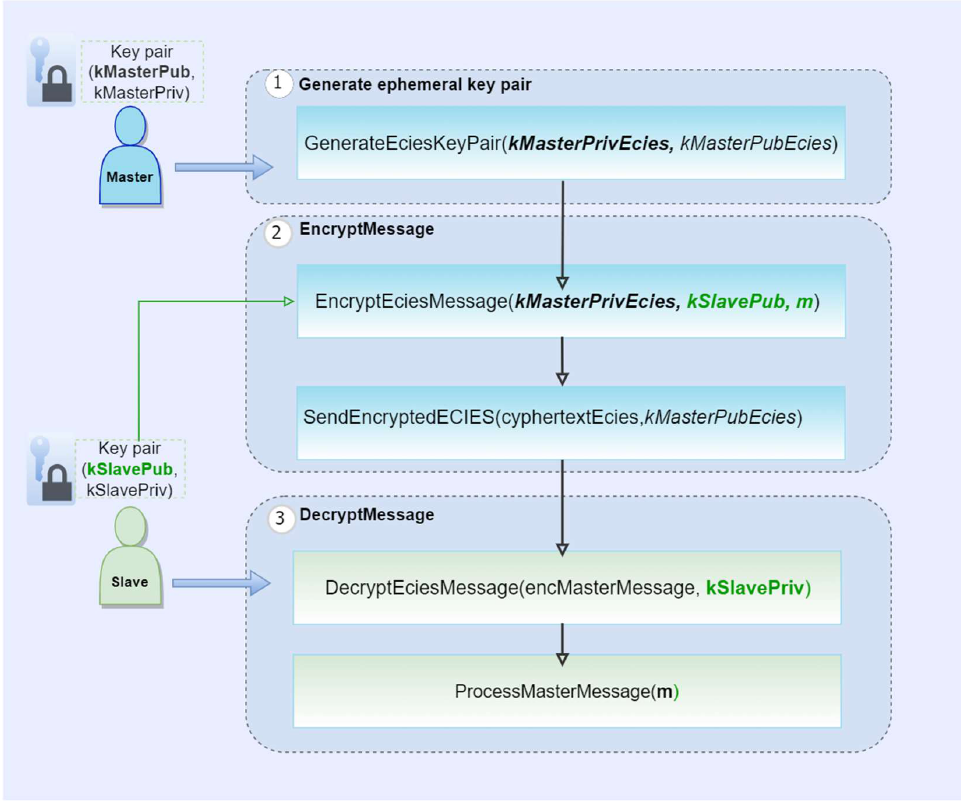
Figure 3. ECIES integrated encryption scheme.